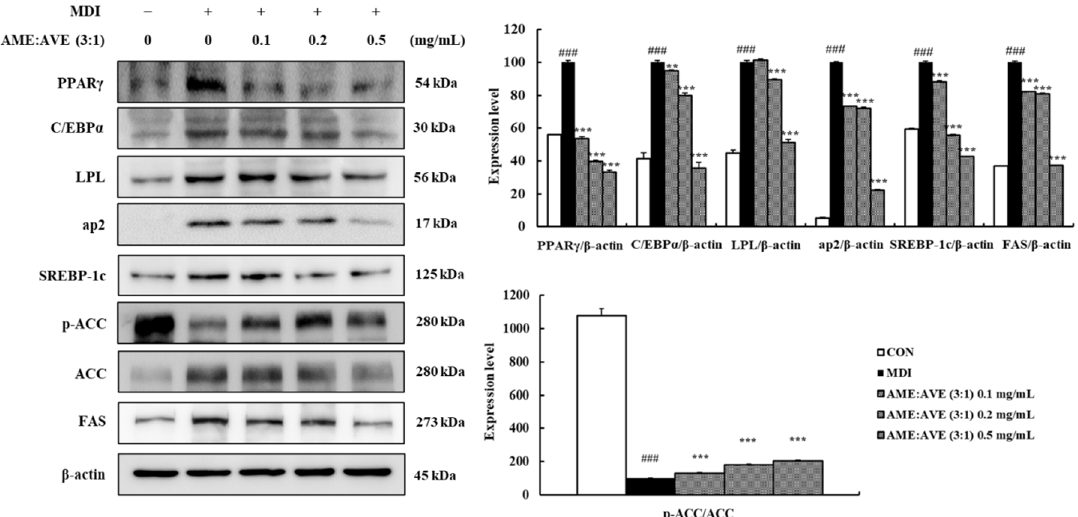
Figure 3. Effects of Atractylodes macrocephala and Amomum villosum extracts (3:1) on levels of down- stream proteins associated with adipogenesis and lipogenesis in 3T3-L1 adipocytes. Western blot bands were analyzed using Image J software. β -actin was used as a control for normalization. Data represent mean ± SD of three independent experiments. CON, only dimethyl sulfoxide (DMSO) treated no differentiation control; MDI, only 3-isobutyl-1-methylxanthine, dexamethasone, and in- sulin treated differentiation control. ### p < 0.001 vs. CON group. ** p < 0.01, and *** p < 0.001 vs. MDI group.